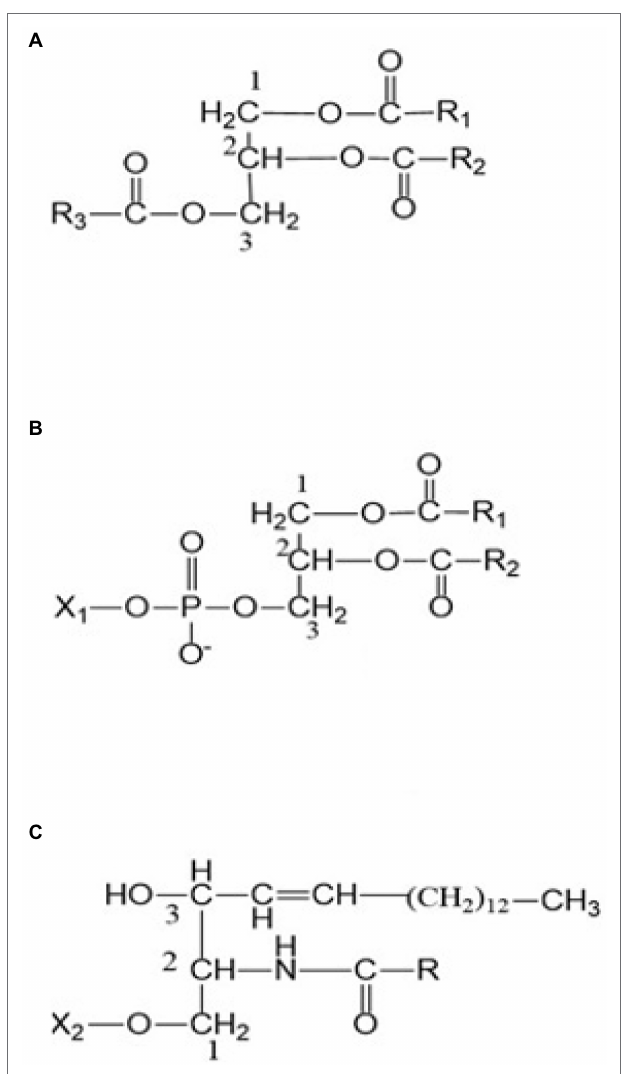
FIGURE 1 | (A) A triacylglycerol (TAG) (B) a phospholipid, and (C) a sphingolipid. R, R 1 , and R 2 are alkyl or alkenyl groups attached to ester carbonyls. X 1 : H, ethanolamine, choline, serine, glycerol, or phosphatidylcholine functional groups. X 2 : H, phosphocholine, glucose, or oligosaccharide functional groups.